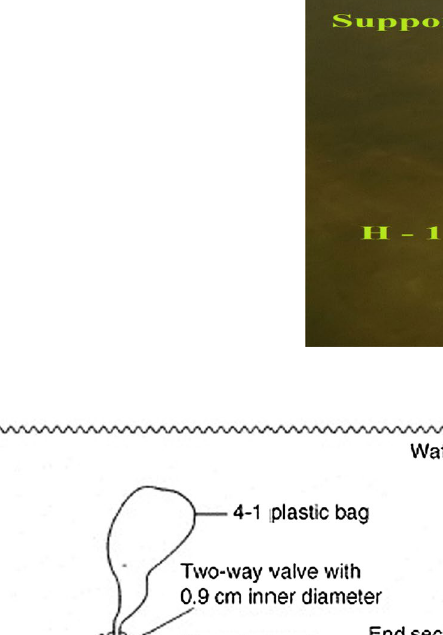
Fig. 2 Mannual seepage meter established for the present study (modified after Lee 1977)